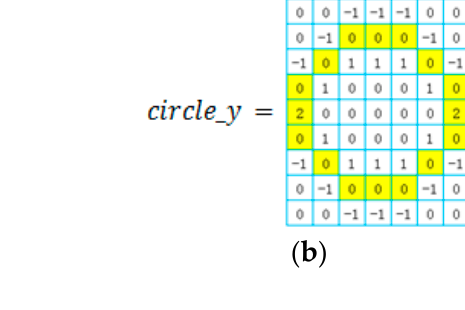
Figure 7. Circle filters.